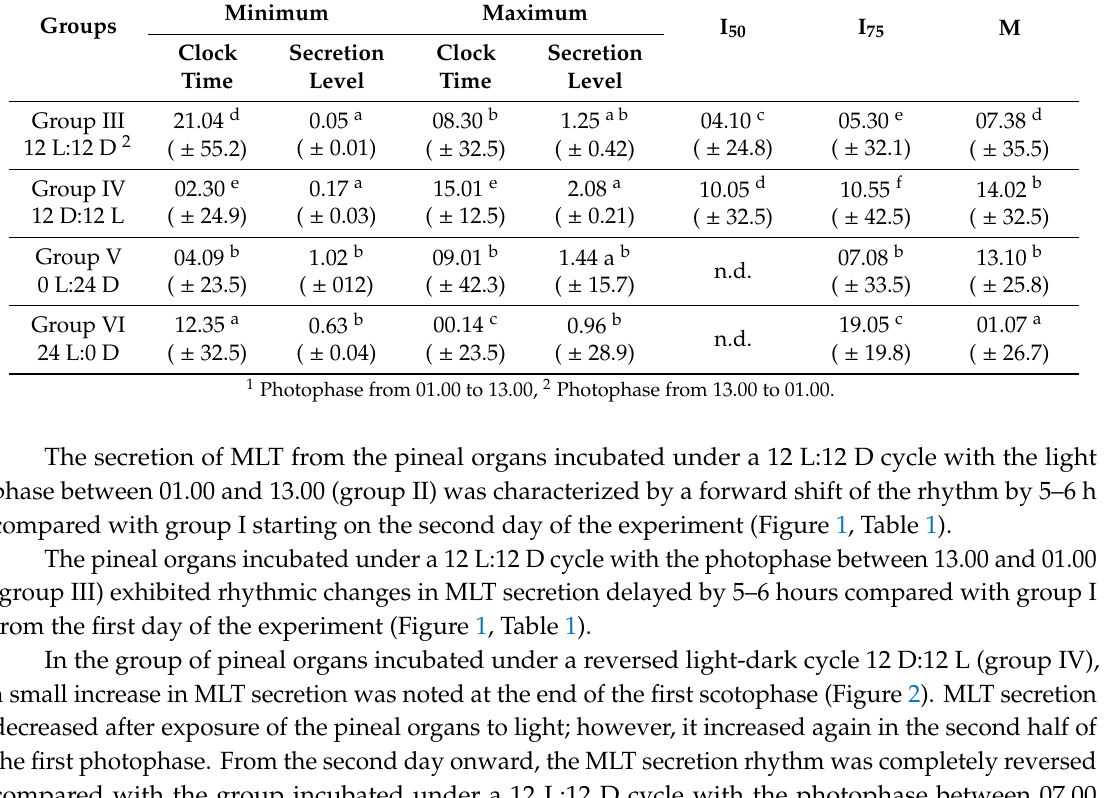
Figure 3. Experiment I. Secretion of MLT (mean) from turkey pineal organs incubated under a 12 L:12 D cycle with the photophase from 07.00 to 19.00 (group I), under continuous darkness (group V) or under continuous illumination (group VI).